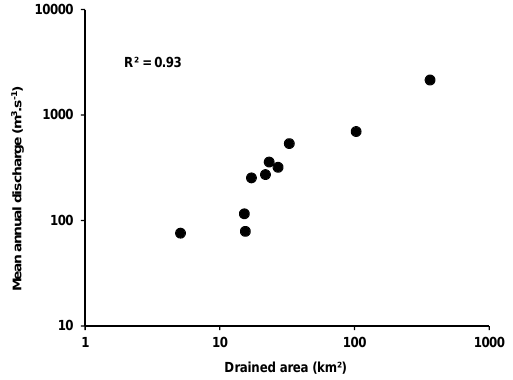
Fig. 3. Relationship between drained area and mean annual discharge in the Upper Paraguay Basin (source ANA/GEF/PNUMA/OEA, 2005).